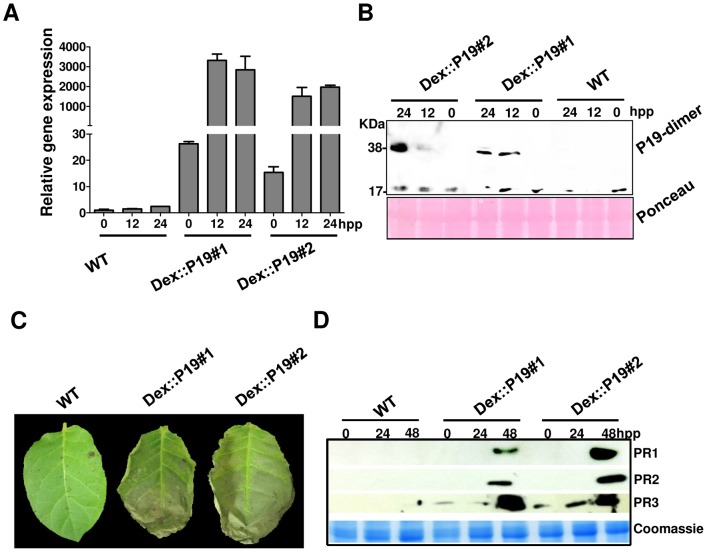
DEX::P19 transgenic plants display defense responses following DEX application.(A–B) Leaves of five week old DEX::P19 transgenic and wild type plants (N. tabacum cv. Xanthi) were sprayed with DEX and the kinetics of P19 accumulation at transcript (A) and protein (B) levels was subsequently analyzed by qPCR and Western analysis, respectively. Actin was used as an internal control. (C) DEX::P19 transgenic or wild type plants were sprayed with DEX, and appearance of HR was assessed 5 days post-DEX application. We observed two and sometimes three bands for P19 dimers. These additional bands appear when P19 is expressed in N. tabacum but not in N. benthamiana. We believe that these additional bands are due to post-translational regulation of P19 by N. tabacum; this regulation might have a biological significance but evidence of this is not known yet. (D) PR protein accumulation at 0, 1 and 2 days post DEX application in wild type and DEX::P19 transgenic lines. Western analysis was conducted using anti-PR1, -PR2 and -PR3 antibodies. Coomassie or ponceau staining of the same extracts is shown to demonstrate equal protein loading. Experiments were repeated three times and showed similar results.